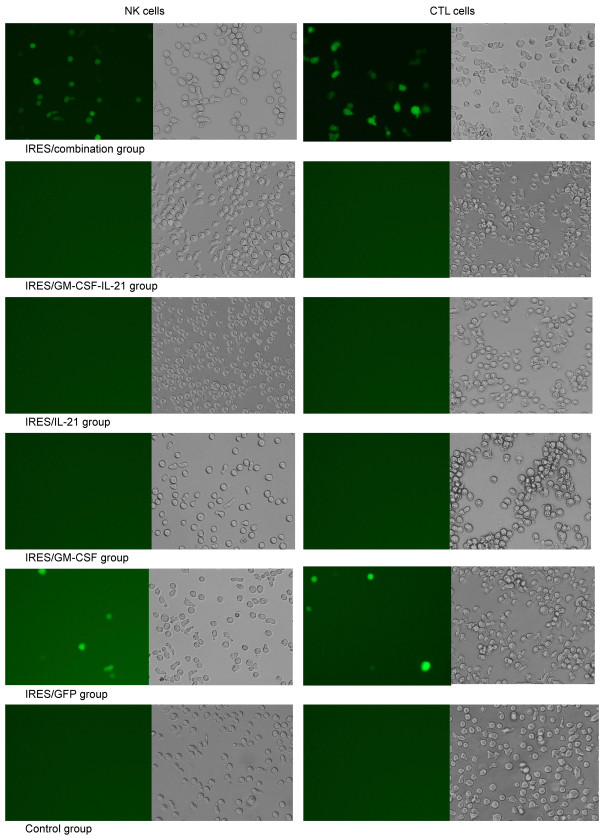
CTL and NK cells were observed by fluorescence microscopy (n = 3). 10 d after treatment, mice spleens were harvested, NK and CTL cells were elected by flow cytometry. Hepatic cancer cells carried the green fluorescent protein (GFP)-expressing vector, and upon injury by CTL and NK cells, the carrying GFP gene vectors is released from the cells in hepatic cancer tissues. GFP-expressing NK and CTL cells were observed by scanning with a fluorescence microscope (× 200 magnification). The right panel represents the phase contrast images of transfected CTL and NK cells that expressed the GFP-fluorescent marker.